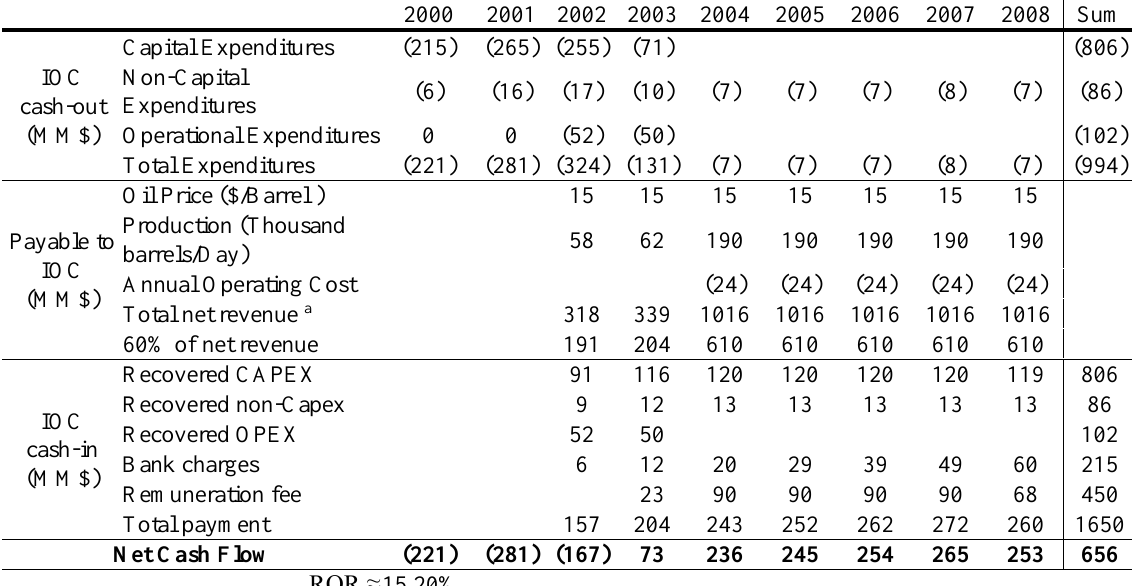
Table 1. International oil company (IOC) Investment in Sorous and Norouz Development